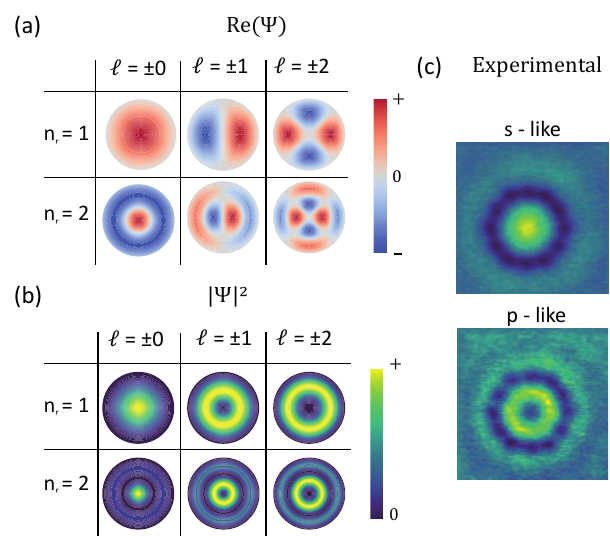
Figure 1: Modeling a circular quantum corral with the particle-in-a-box model. (a) The real part of the wavefunction enclosed in a circular well, showing its shape for different quantum numbers. (b) | Ψ | 2 , which is proportional to the differential con- ductance in STM. (c) Differential conductance maps of a small quantum corral at two energies; -0.17 V and 0.21 V. These correspond to the (cid:96) = 0, n = 1 (1 s ) and (cid:96) = 1, n = 1 (1 p )